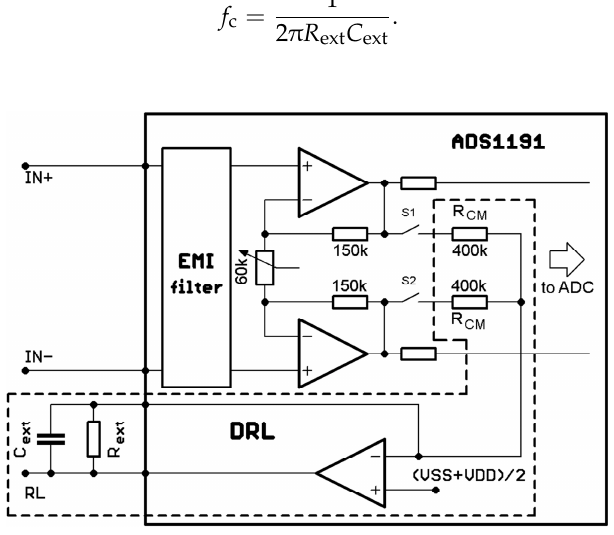
Figure 4. Part of a functional block diagram with the Driven-Right-Leg (DRL)